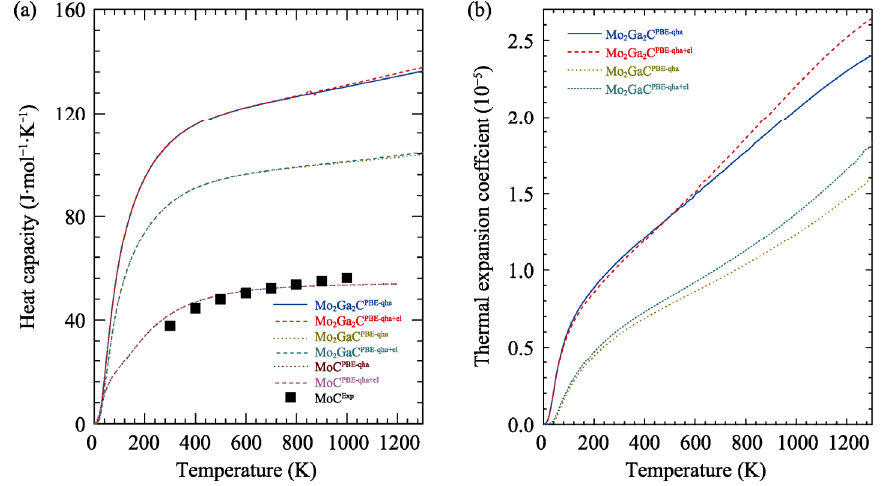
Fig. 5 (a) Heat capacity and (b) thermal expansion of Mo 2 Ga 2 C, while “Exp” means the data from Ref.